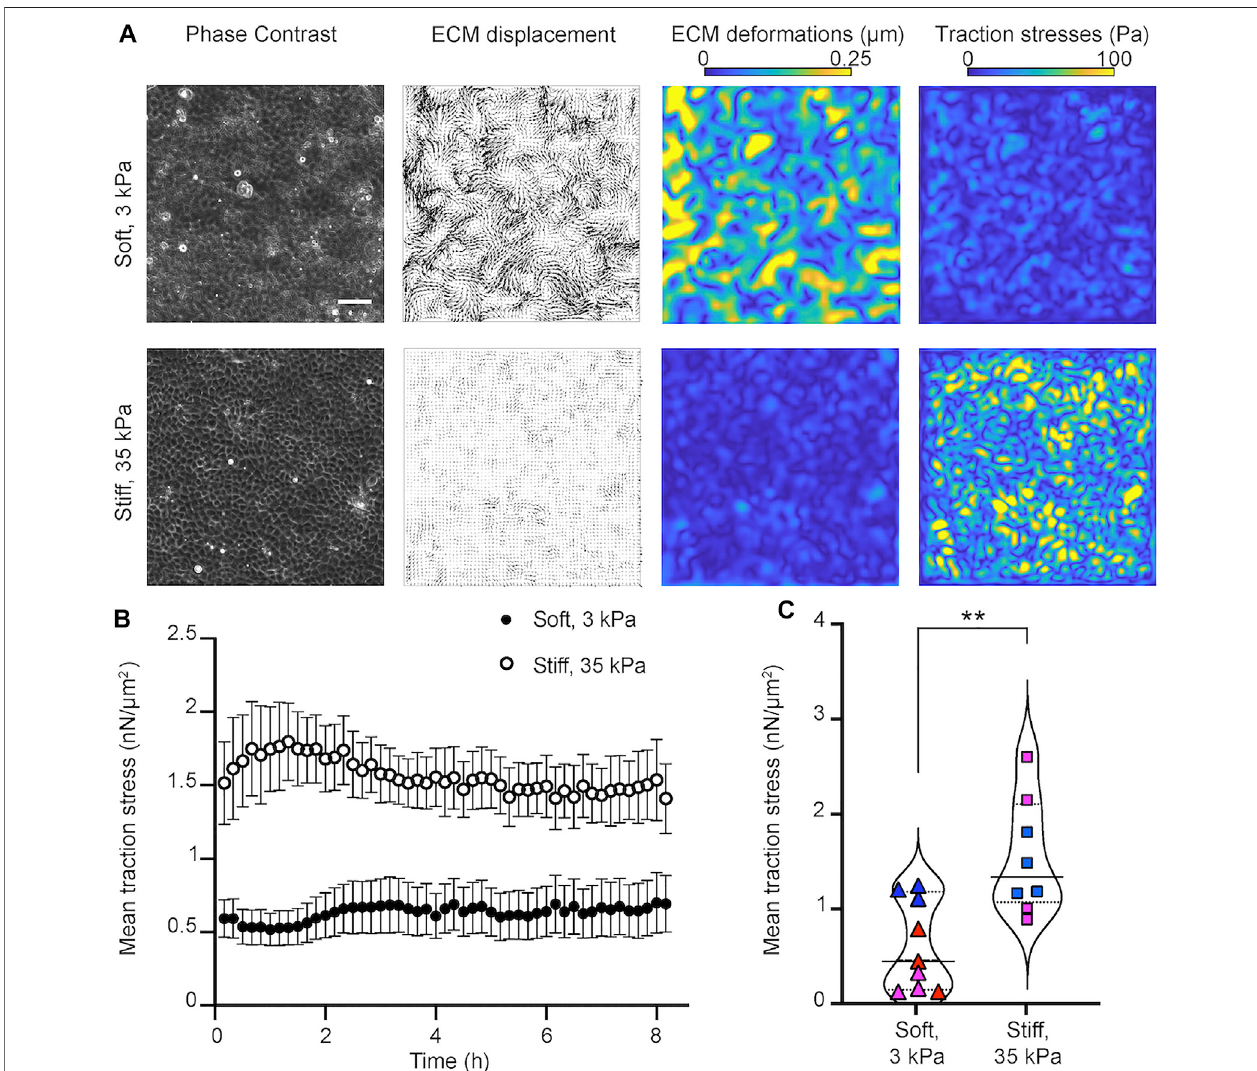
FIGURE2| Epithelialcellsinmonolayerexerthighertractionstresseswhenresidingonstiffasopposedtosoftermatrices. (A) Tractionforcemicroscopyperformed on MDCK cells residing on soft, 3 kPa (upper row) and stiff, 35 kPa (bottom row) hydrogels. Columns of a representative time instance show: phase contrast image of cells,displacementsimpartedbythecellsonthehydrogel(vectors),correspondingdeformations(colormapshowsmagnitude, μ m)andtractionstressesexertedbycells (colormap shows magnitude, Pa). Scale bar is 50 μ m. (B) Plot ofthe mean traction stress magnitude ( y -axis)versustime ( x -axis). Mean ±SEM are shown for N = 8 and N = 9 TFM recordings performed on stiff 35 kPa and soft 3 kPa gels, respectively. (C) Violin plots of the mean traction stress magnitude for all recordings and time points shown in panel (B) . Symbols show the time average of the mean traction stress for each recording. Same color points correspond to recordings performed the same day on different wells. Solid line indicates the mean and dotted the STD of all time averages. **: p < 0.001, Wilcoxon Ran Sum test.